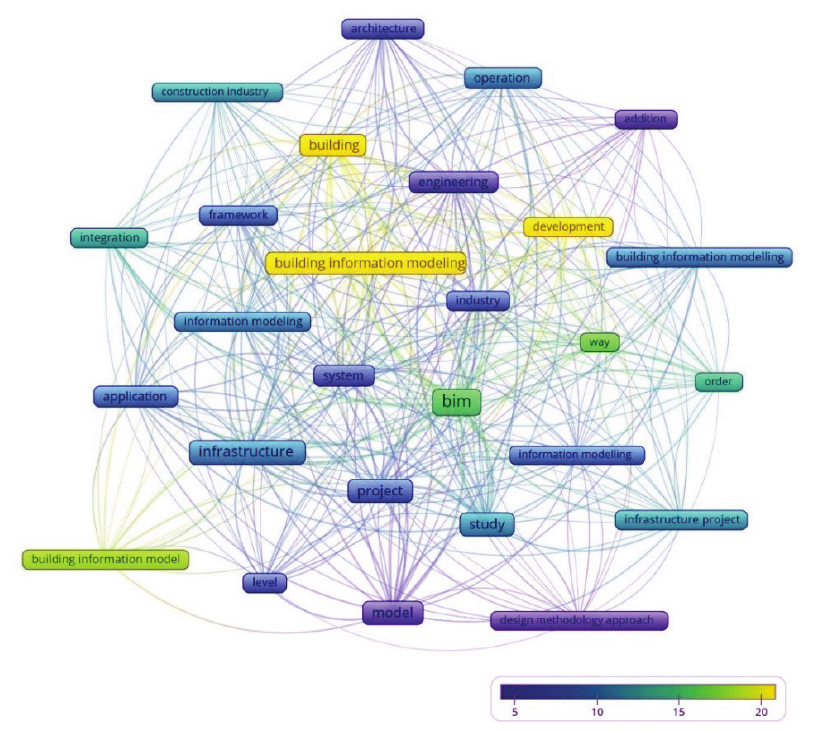
Figure 4. Co-occurrence map of terms by average